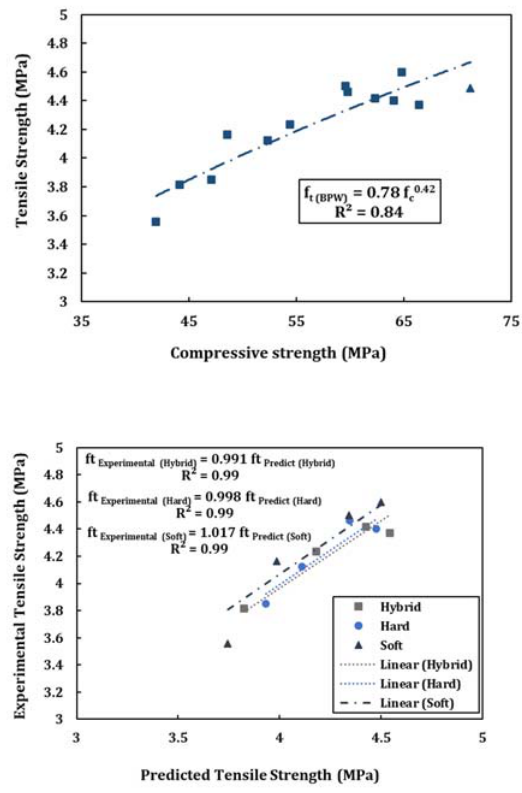
Figure 11. The relation between tensile strength and compressive strength of BPW-containing concrete and correction factors for each type of BPW.